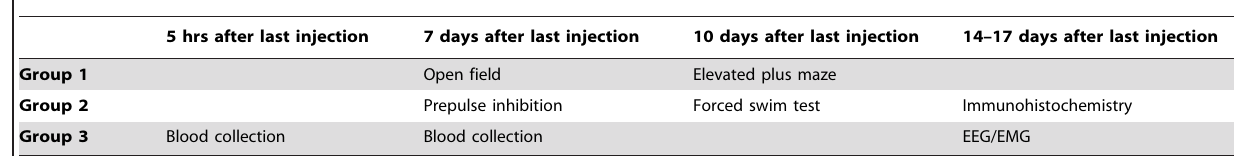
Table 1. Time schedule of